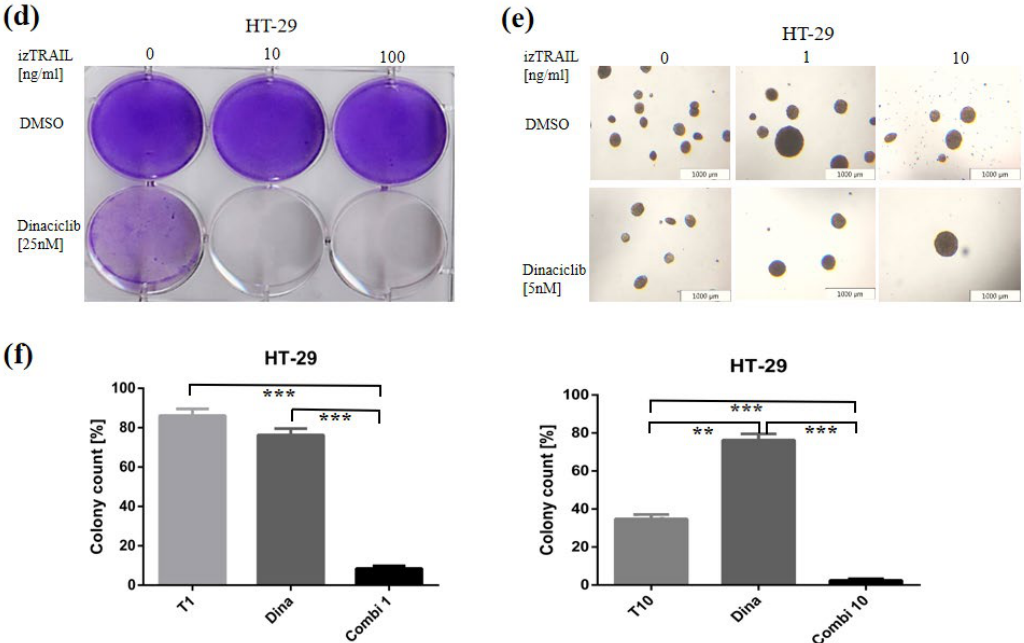
Figure 3. Synergistic effect of Dinaciclib treatment in combination with izTRAIL. Five colon cancer cell lines (HT-29, HCT-116, SW-480, SW-620, and DLD-1) were treated in different ways. ( a ) using izTRAIL (0, 0.1, 1, 10, 100 ng/mL) and ( b ) Dinaciclib (0, 3.125, 6.25, 12.5, 25, 50, 100 nM) for 24, 48, and 72 h. ( c ) preincubated for 4 h with the CDK9 inhibitor Dinaciclib (25 nM) and subsequently treated with izTRAIL at the indicated concentrations (0, 0.1, 1, 10, 100 ng/mL). Cell viability was analyzed by MTT viability assay. Results were normalized to DMSO-treated cells. All values are presented as means ± SD of three independent experiments. ( d ) 50,000 cells/well HT-29 seeded into 6-well plates and were treated with solvent (DMSO) or Dinaciclib (25 nM) for 1 h and subsequently stimulated with izTRAIL for 24 h. Long-term survival was visualized after 7 days by crystal violet staining. ( e ) HT-29 (2000 cells/well) were seeded into 6-well plates in soft agar supplemented with solvent (DMSO), izTRAIL (1, 10 ng/mL), and Dinaciclib (5 nM), respectively, alone or in combination (T1: 1 ng/mL izTRAIL, T10: 10 ng/mL izTRAIL, Combi 1: 1 ng/mL izTRAIL + 5 nM Dinaciclib, Combi 10: 10 ng/mL izTRAIL + 5 nM Dinaciclib). Formed colonies were photographed for three times in a bright field at specific positions located on each fan-shaped center of every well divided into three equal parts and subsequentially visualized and quantified using MTT staining after 21–28 days. One of five independent experiments is shown. ( f ) All values are presented as means ± SD. ** p < 0.01, *** p < 0.001; Student’s t -test.